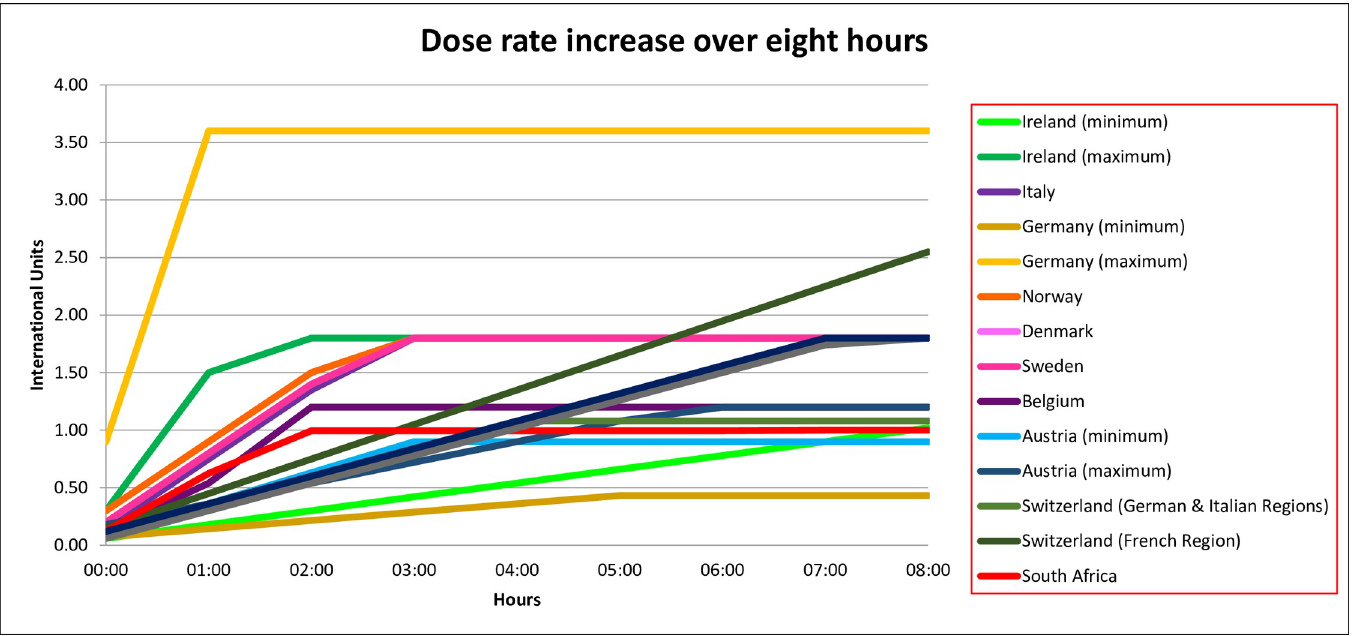
IU/hour dose rates increases plateaued at two hours in three regimens, at three hours in five regimens and between four and eight hours in the remaining regimens. The IU/hour dose rate increases had not plateaued at eight hours in four regimens. The dose rate increase over an eight-hour period is presented graphically in Fig 1. https://doi.org/10.1371/journal.pone.0227941.t010 amount of oxytocin IU that would be infused over eight hours of labour. The total amount of oxytocin that would be infused was estimated at 27.00 IU in Germany’s maximum regimen, 11